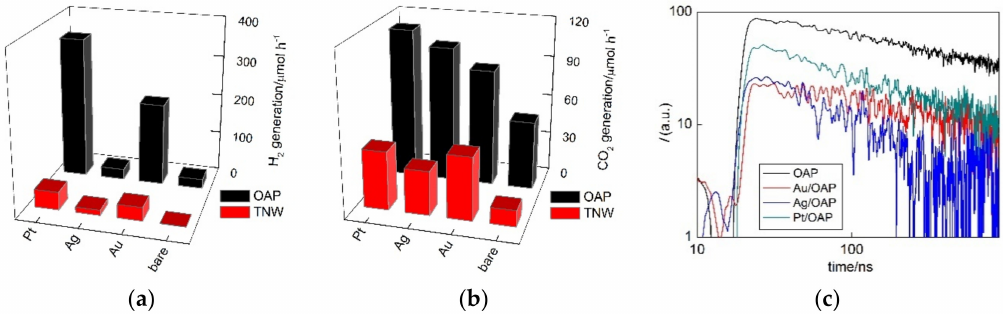
Figure 9. UV-vis-photocatalytic activity ( a , b ) of bare and NM-modified OAP and TNW samples for: ( a ) Methanol dehydrogenation and ( b ) decomposition of acetic acid; and ( c ) the time course of the time-resolved microwave conductivity (TRMC) signal for bare and NM-modified OAP samples after UV excitation (355